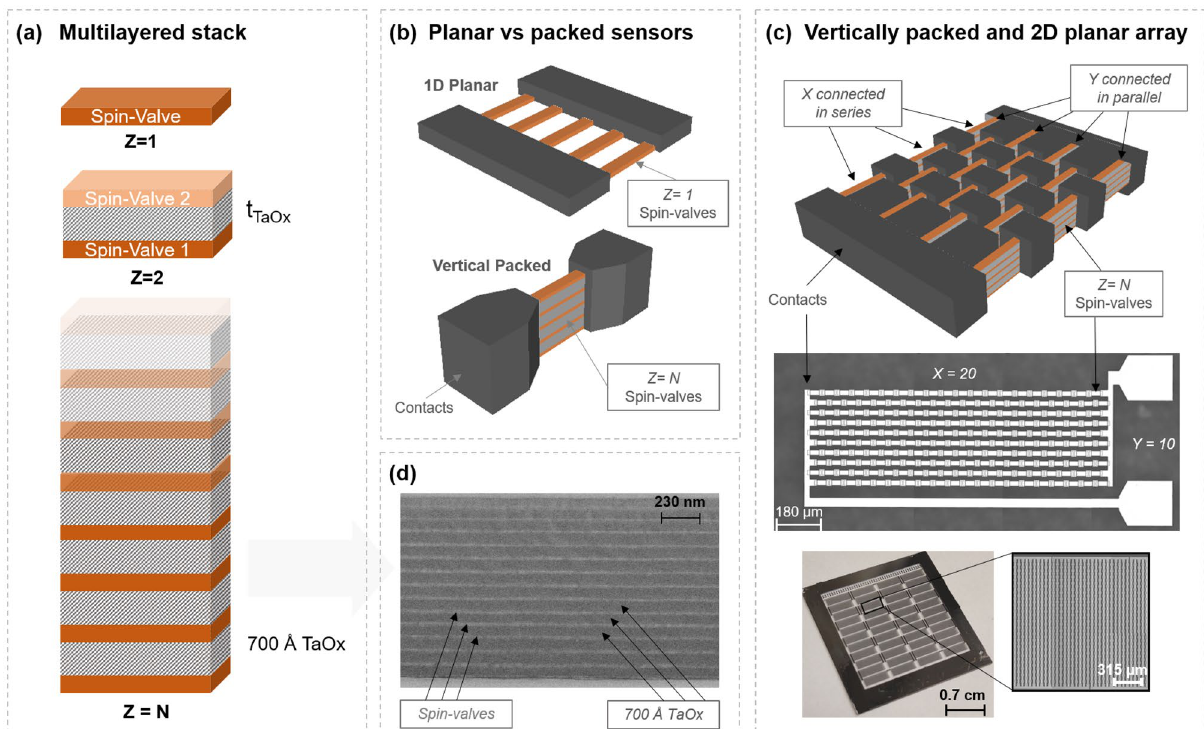
Figure 1. Designs of the spin-valve arrangements considered in this study. ( a ) Scheme of vertically packed multilayered thin-films with Z = 1 for single spin-valve, Z = 2 for two vertically packed spin-valves with different TaOx spacer thicknesses (from 500 to 1100 Å), and Z = 5, 10, N for multiple vertically packed spin- valves with fixed TaOx thickness of 700 Å. ( b ) Scheme of one-dimensional planar array versus a vertically packed array; both have the elements connected in parallel. ( c ) Scheme of vertically packed ( Z ) two-dimensional ( XY ) array of spin-valves ; optical images of patterned device containing 1000 sensors ( X = 20 , Y = 10 , Z = 5 ) and the final device with best performance showing 440,000 elements. ( d ) Scanning electron microscopy (SEM) cross sectional image of a Z = N multilayer. The bright layers corresponds to the spin-valves while dark thick layers are the TaOx (700